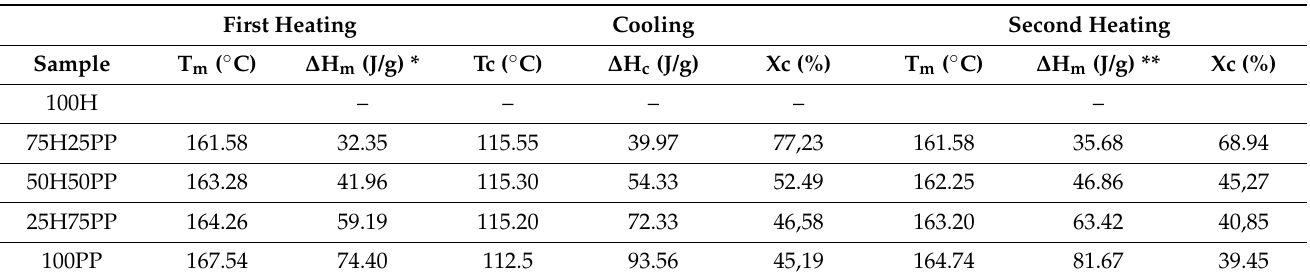
Table 5. DSC data for PP and its